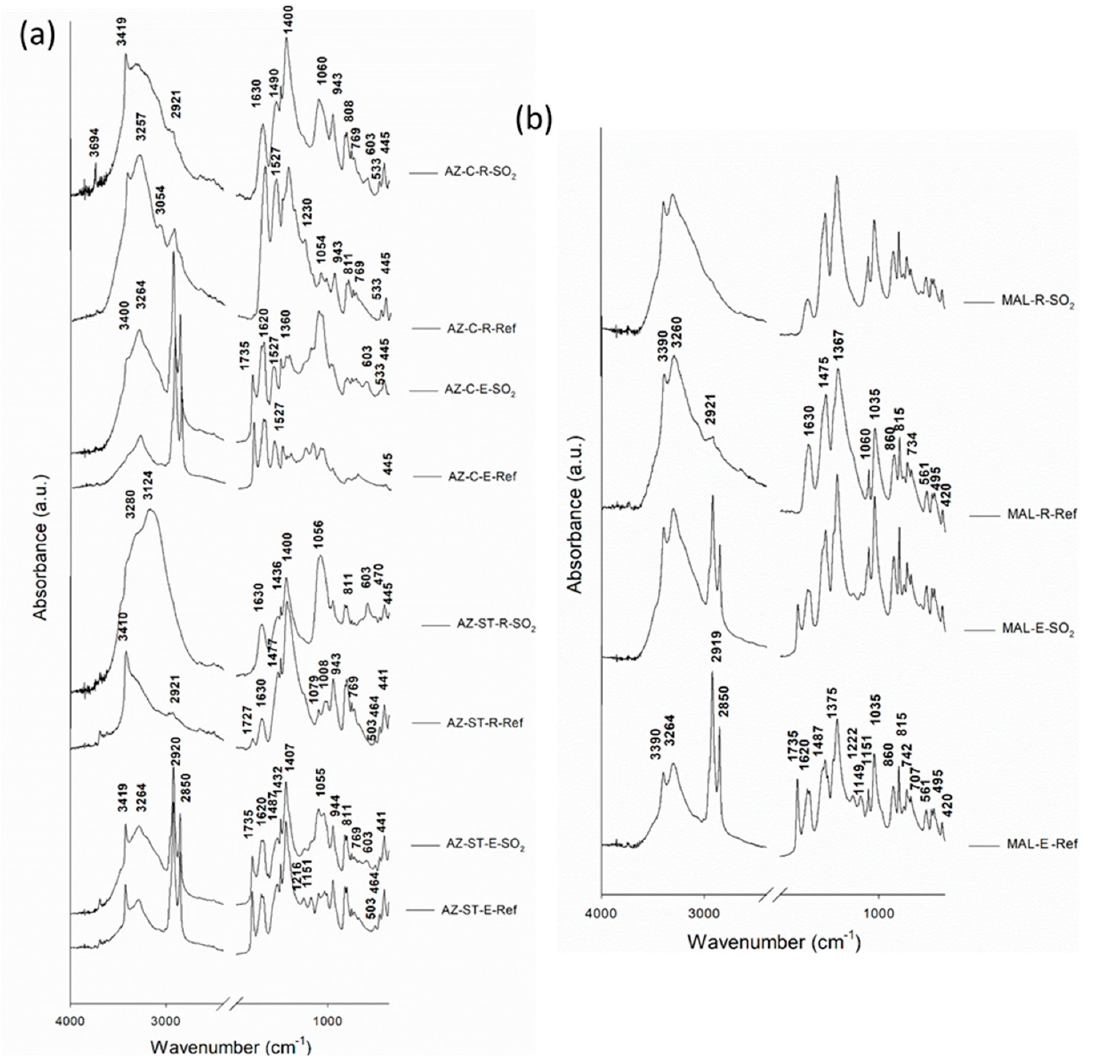
Figure 5. ATR-FTIR (absorbance) spectra for reference (Ref) and aged (SO 2 ) paint mock-ups. Please see Table 1 for paint labeling. ( a ) AZ-based paints; ( b ) MAL-based paints.